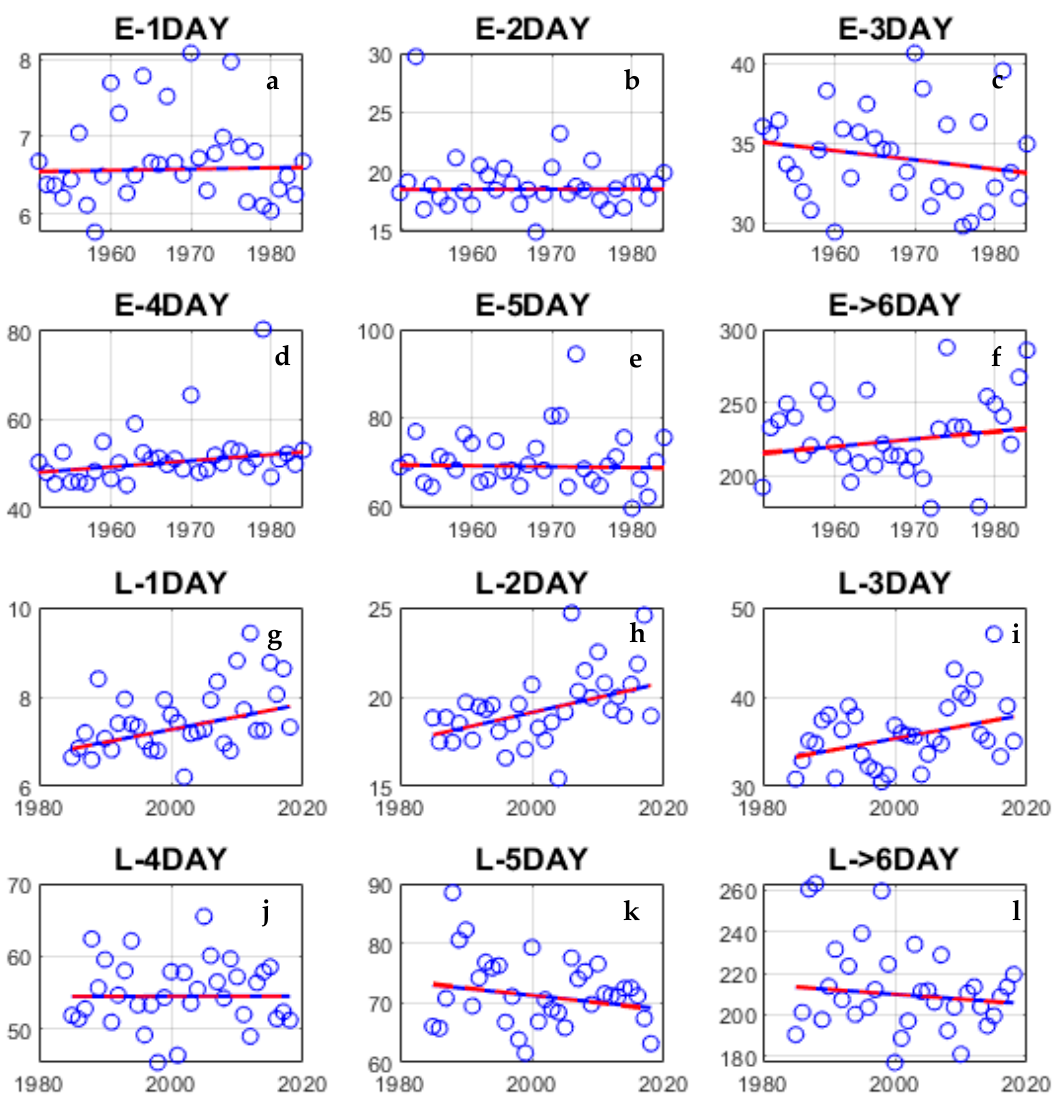
Figure 5. MK test for continuous rainfall magnitude over India for 1DAY to 5DAY and more than 6 DAY. On each panel prefix, “E” means, data considered from 1951 to 1984, while prefix “L” means, data consideration from 1985 to 2018. Continuous rainfall of 1 day, 2 days, 3 days, 4 days and N days are referred as 1DAY, 2DAY, 3DAY and NDAY respectively. The blue line shows the trend, while the red dotted lines show confidence at a 95% significance level here.